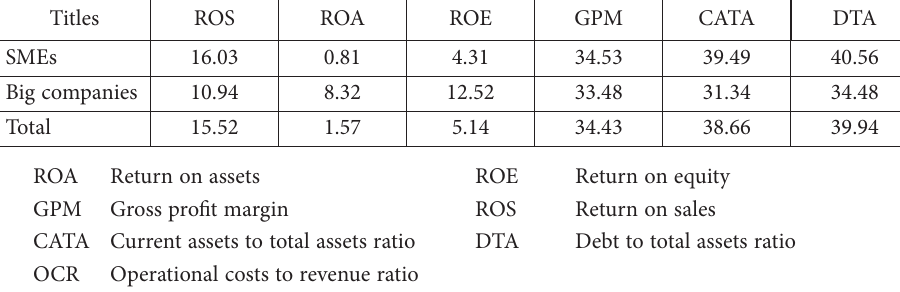
Table 5. Financial ratios of the clusters (source: author’s calculation (average of 4 years)) (percentage)